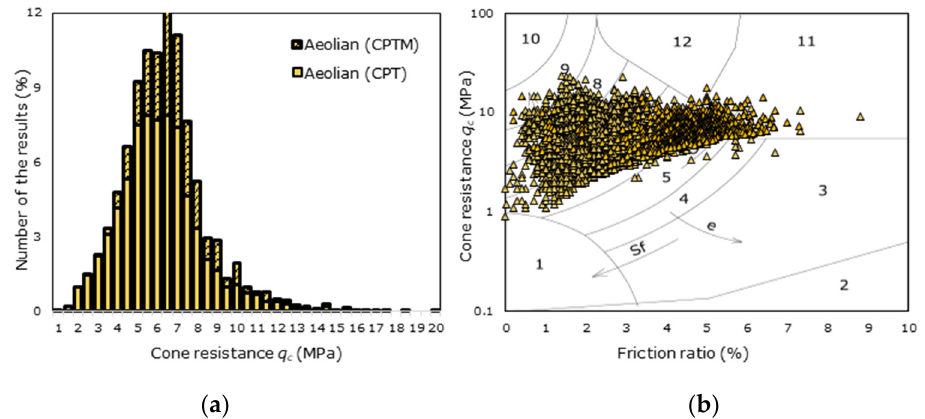
Figure 8. Summary of results for the aeolian facies: ( a ) distribution of q c values and ( b ) sounding parameters plotted against Robertson’s chart (1—sensitive fine grained; 2—organic material; 3—clay; 4—silty clay to clay; 5—clayey silt to silty clay; 6—sandy silt to clayey silt; 7—silty sand to sandy silt; 8—sand to silty sand; 9—sand; 10—gravely sand to sand; 11—very silty fine grained; 12—sand to clayey sand; D r —density ratio; OCR—overconsolidation ratio; Sf—sensitivity factor; e—void ratio).